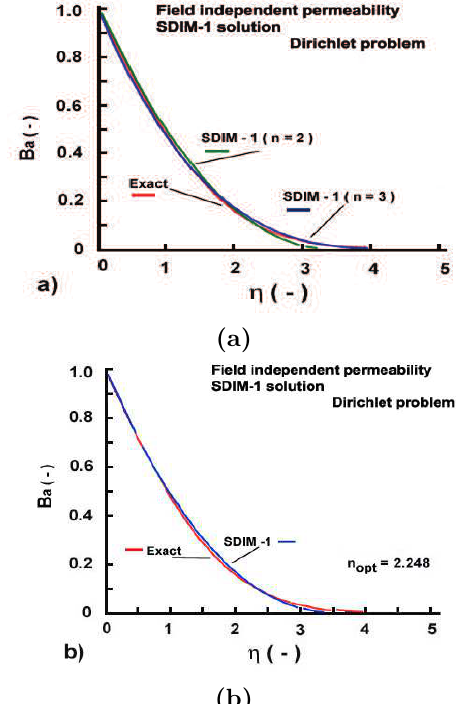
Figure 2. Approximate profiles de- veloped by SDIM-1 approach and Dirichlet problem: for stipulated ex- ponent n = 2 (a) and optimal n opt = 2 . 248 (b), compared to exact solu-